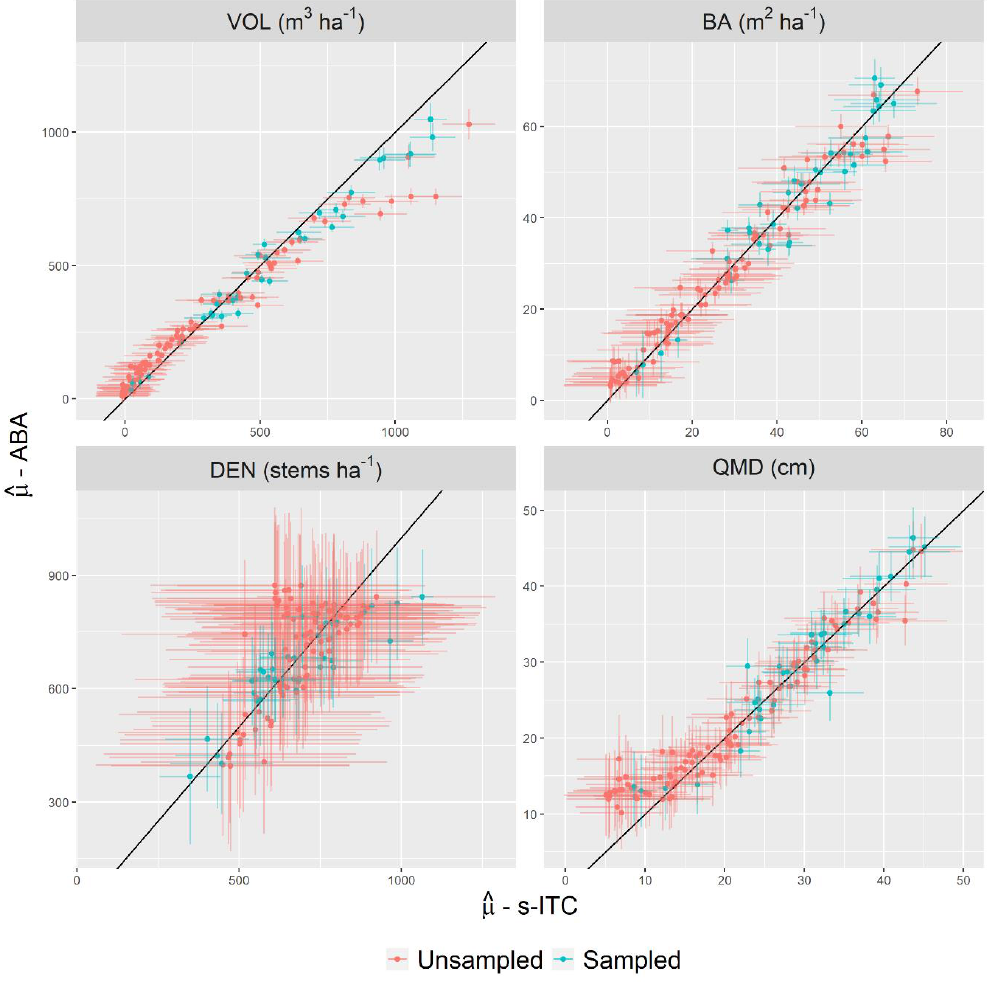
Figure 4. Predictions of area-level parameters for VOL, BA, DEN, and QMD for s-ITC models and ABA models. Whether or not the stand had at least one field plot is indicated by the color of the point. The confidence intervals are shown as horizontal bars for s-ITC and vertical bars for